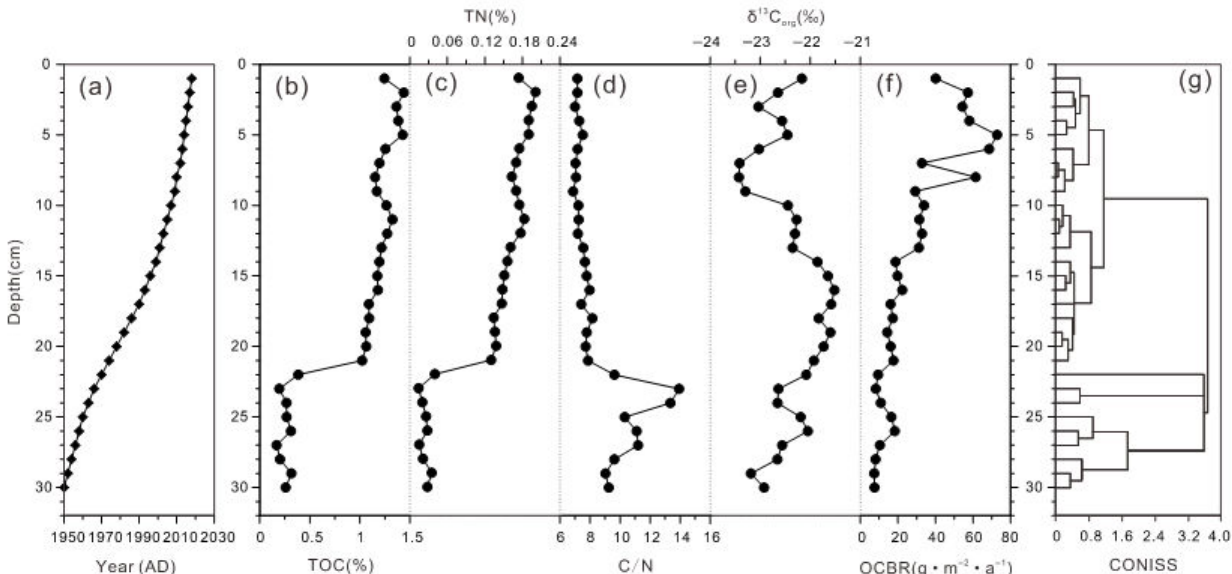
Figure 3. The depth–age model ( a ), the variation of the environmental proxies in the lake sediments of the North Aral Sea: ( b ) total organic carbon (TOC), ( c ) total nitrogen (TN), ( d ) atomic ratio of TOC and TN (C/N), ( e ) stable organic carbon isotope ( δ 13 C org ), and ( f ) organic carbon burial rate (OCBR), and ( g ) stratigraphically constrained cluster analysis (CONISS) results for the environmental